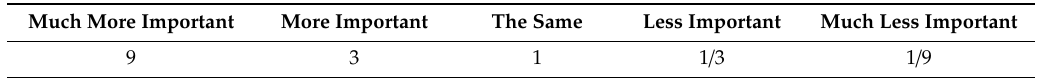
Table 4. Comparison matrix values.